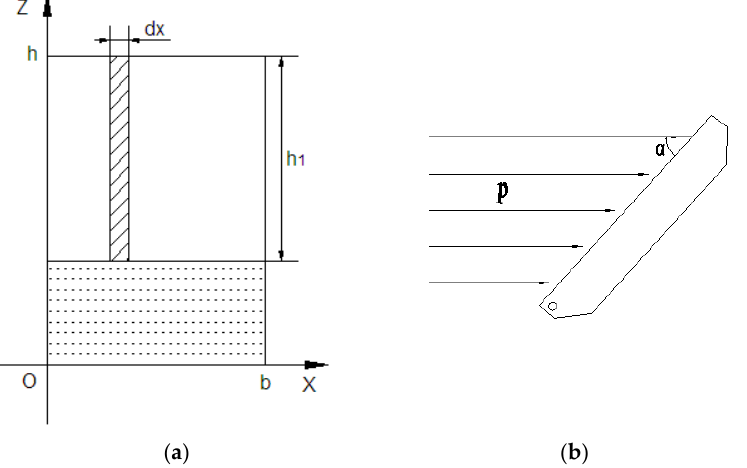
Figure 2. ( a ) Diagram of the herringbone gate. ( b ) Schematic diagram of the her-ringbone gate subjected to wind pressure.